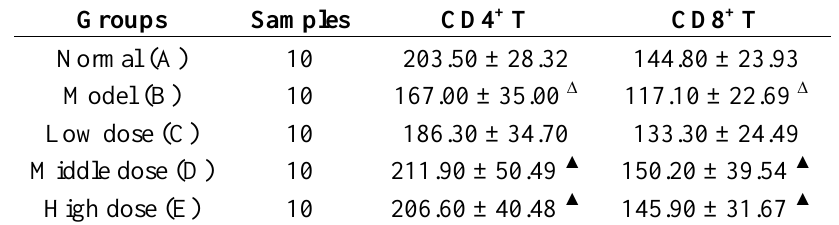
Table 8. Effect of FBTE on the number of CD4 + and CD8 + T lymphocytes ( x ±